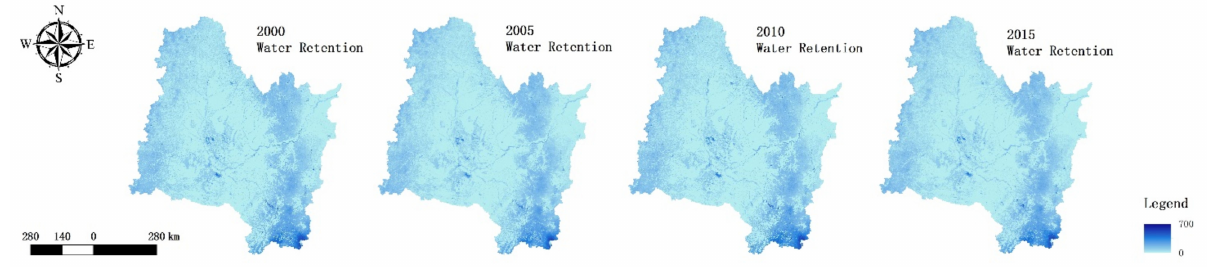
Figure 3. Distribution map of water